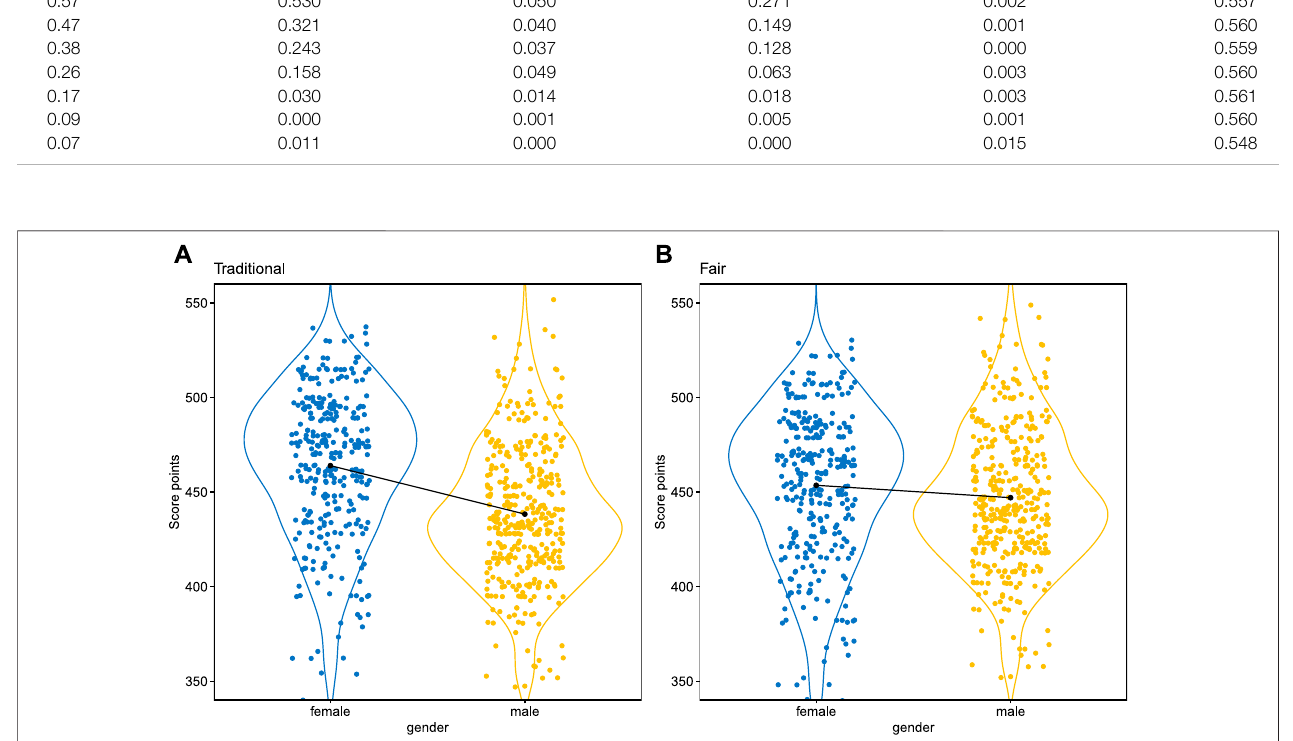
FIGURE 3 | Protected attribute dependence plot of the traditional scorecard (A) vs. the fairness-corrected scorecard (B) . Note that the calibrated versions of the scores are used with 500 points at odds of 1/19 and 20 points to double the odds.